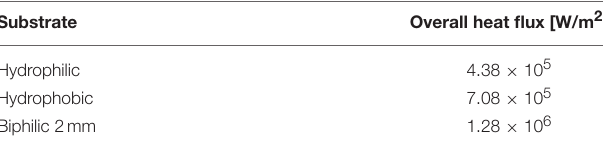
TABLE 1 | The overall heat flux through the condenser surface for hydrophilic, hydrophobic, and 2mm biphilic substrates.